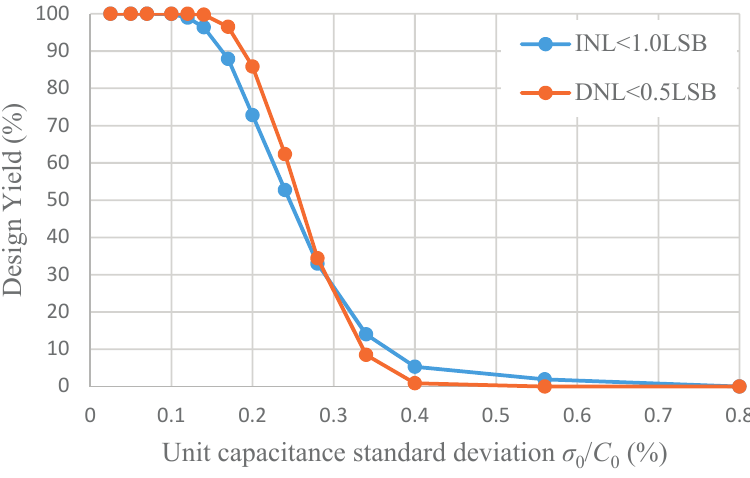
Figure 14. Design yield as a function of the unit capacitance standard deviation σ 0 / C 0